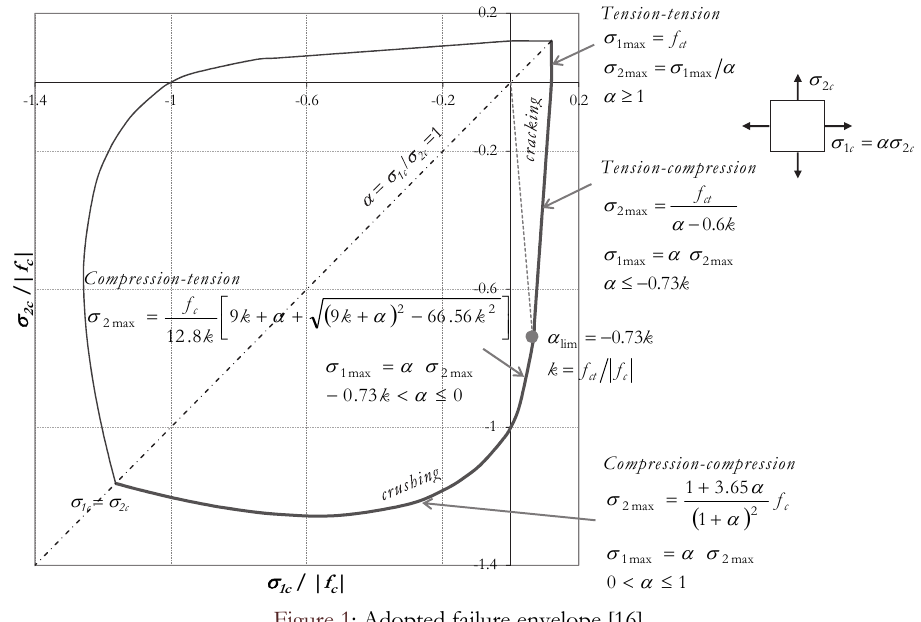
Figure 1: Adopted failure envelope